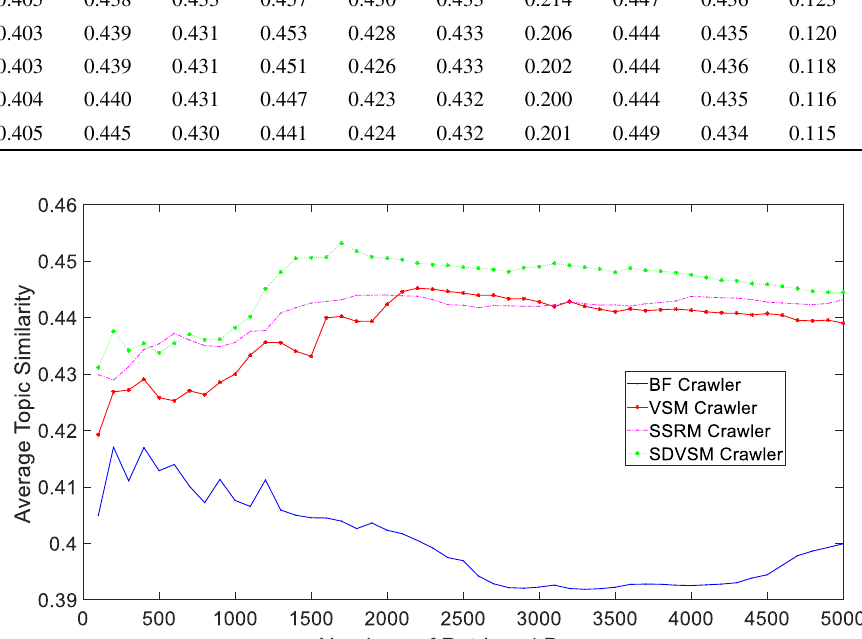
Fig. 11 The comparison of the average topic similarity for four focused crawlers based on the second group